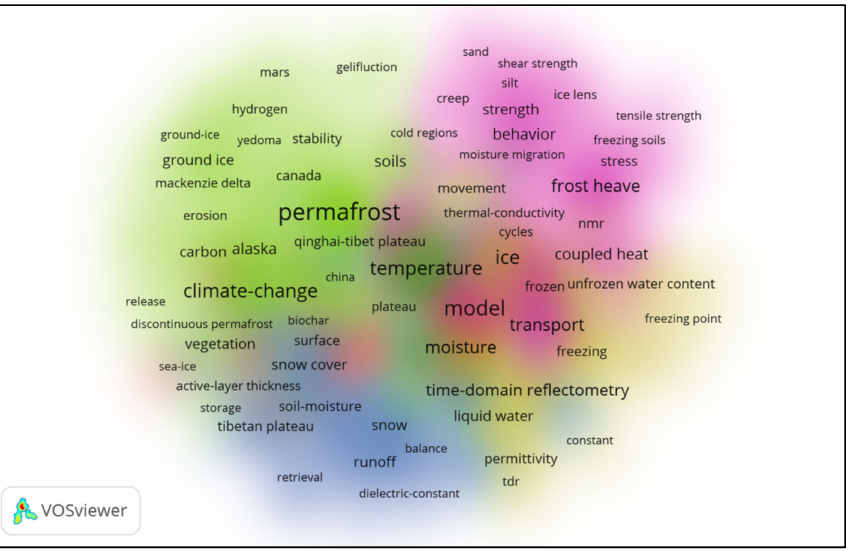
Figure 6. Cluster density visualization map of 105 keywords each occurs more than 10 times in the title, abstract, and keyword list (produced by VOSviewer1.6.15). Note: Font size and